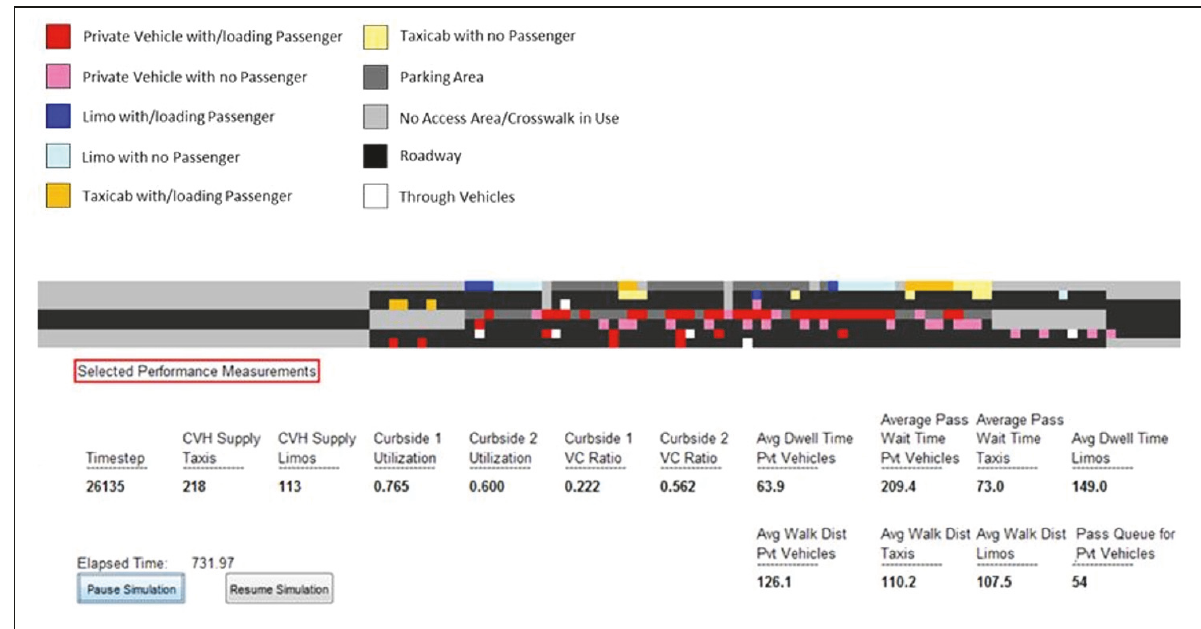
Figure 10: GUI simulation output